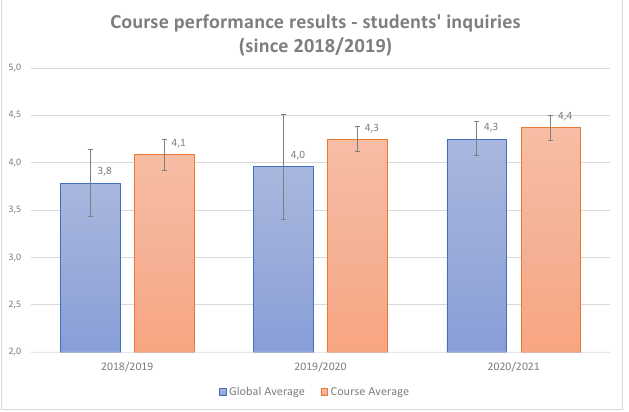
Figure 24. Students’ inquiries